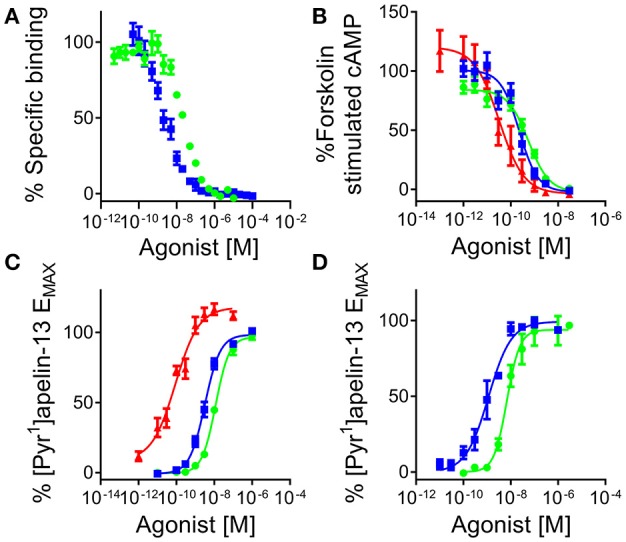
[Pyr1]apelin-13(1–12) binds to and activates the human apelin receptor. (A) Competition binding curve for [Pyr1]apelin-13 () and [Pyr1]apelin-13(1–12) () in human left ventricle (n = 3). In cell based assays [Pyr1]apelin-13 (), [Pyr1]apelin-13(1–12) (), and apelin-17 () (B) inhibited forskolin-stimulated cAMP production; (C) induced β-arrestin recruitment and (D) triggered apelin receptor internalization.